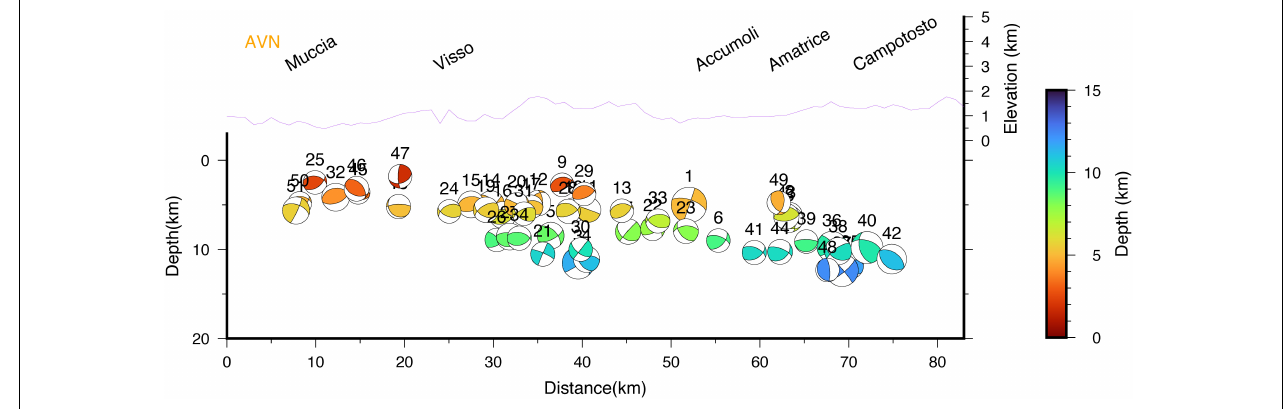
FIGURE 11 | Seismic cross-section along the trace reported in Figure 10 .